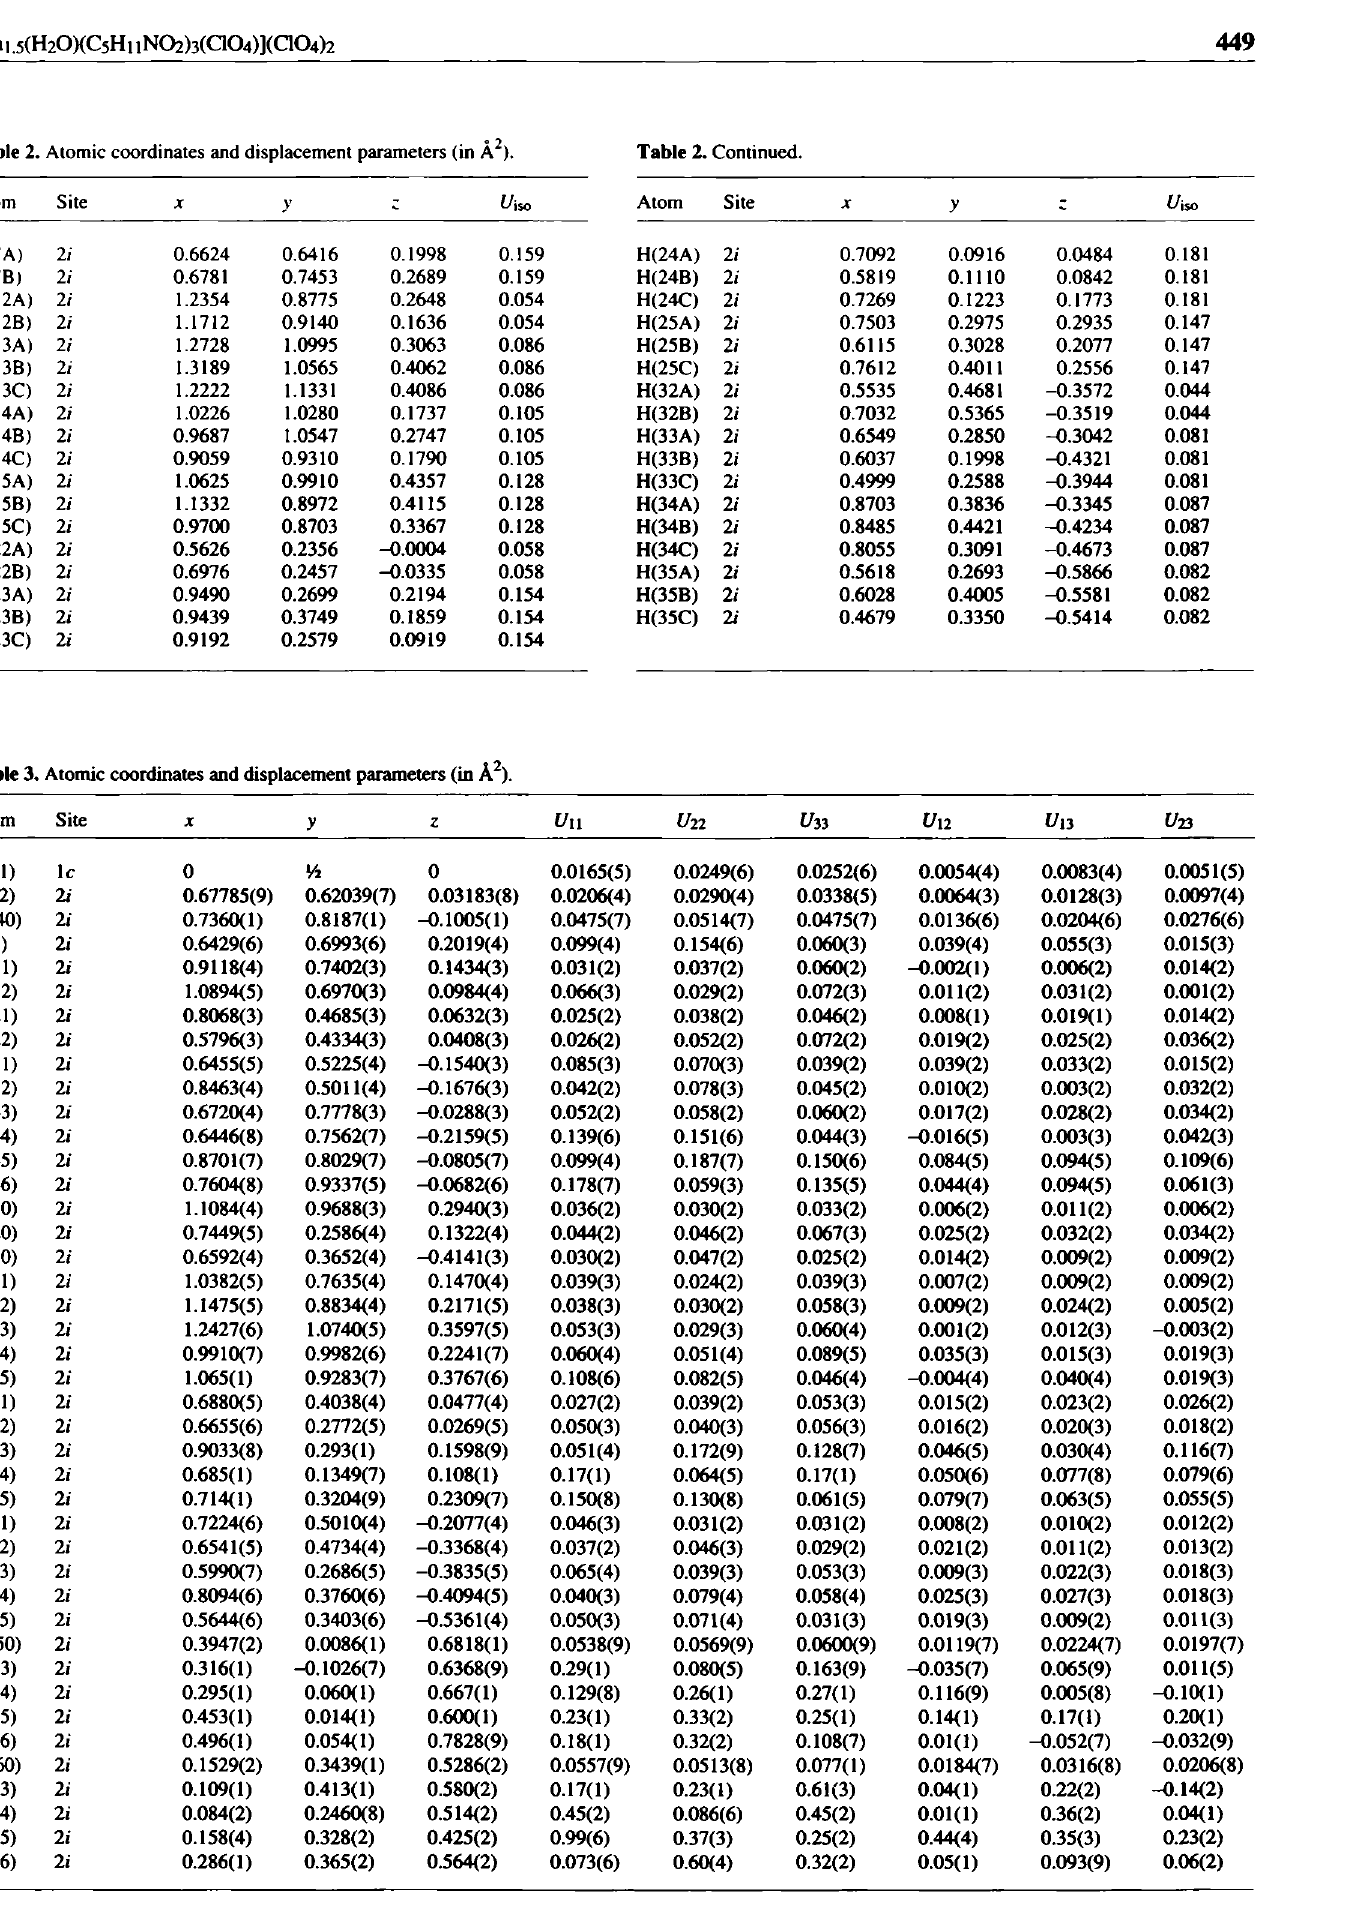
Table 2. Atomic coordinates and displacement parameters (in À ).